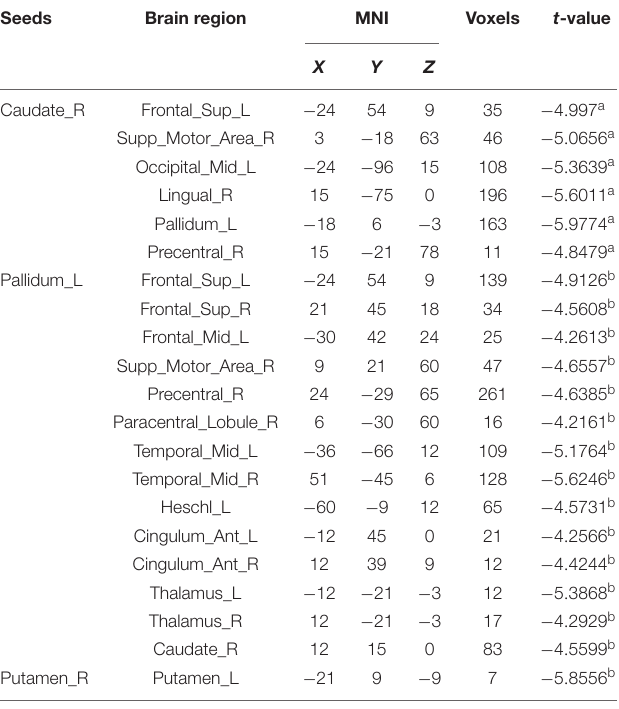
TABLE 3 | Decreased functional connectivity in iRBD patients compared to controls. Seeds Brain region